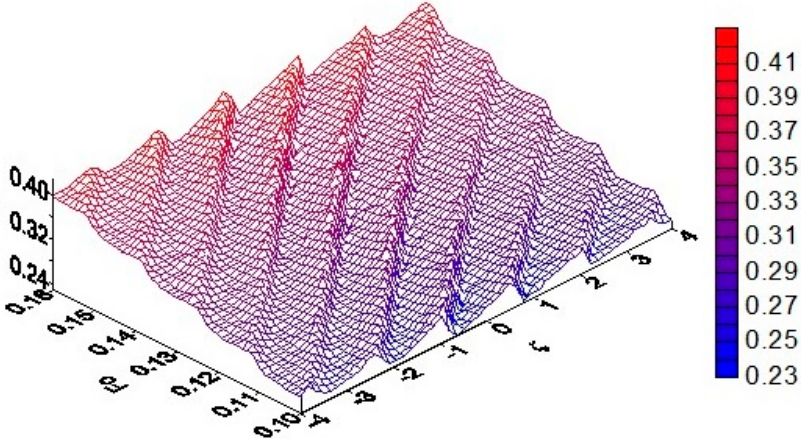
Figure 6. The axial distribution of the temperature along the generatrix of cylinder of the helix ξ = 0.8, θ = 0° during four periods of screw rotation.